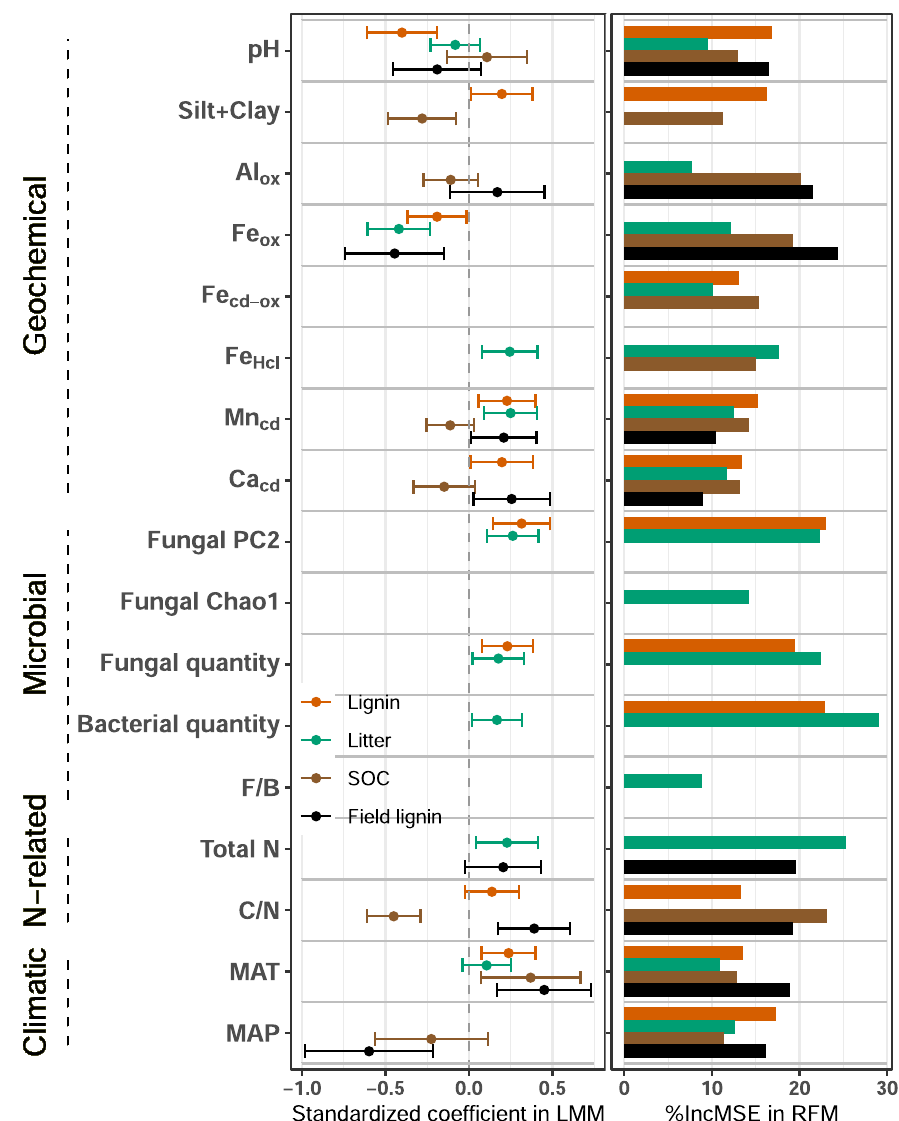
Fig. 4 | Effects of predictors on cumulative lignin, litter, and soil organic car- bon(SOC)decompositionestimatedfromlinear-mixedmodels(LMM,left)and random forest models (RFM, right). Predictors correspond to those in Supple- mentary Table 2. R 2 fi xed and R 2 model represent variance explained by fi xed effects and fi xed + random effects in the LMM, respectively; R 2 RF represents variance explained by the RFM. For lignin decomposition (orange, n =155 biologically independent samples), R 2 fi xed =0.43, R 2 model =0.45, R 2 RF =0.51; for litter decom- position (green, n =155 biologically independent samples), R 2 fi xed =0.49,